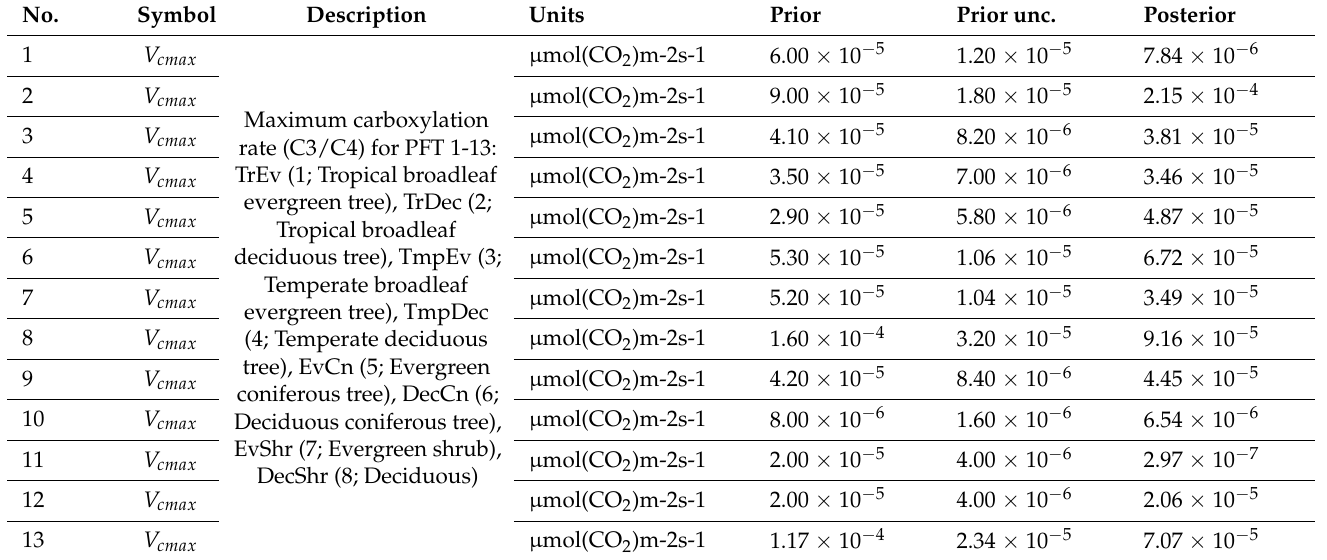
Table A2. CCDAS optimized parameters and their changes in